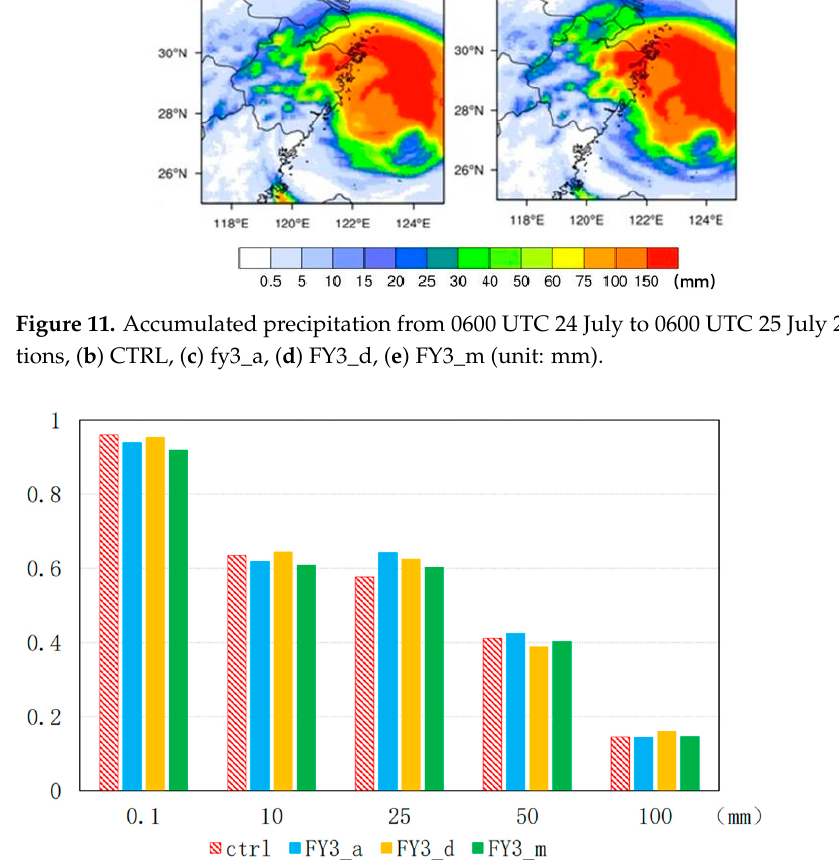
Figure 11. Accumulated precipitation from 0600 UTC 24 July to 0600 UTC 25 July 2021 ( a ) observa ‐ tions, ( b ) CTRL, ( c ) fy3_a, ( d ) FY3_d, ( e ) FY3_m (unit: mm).